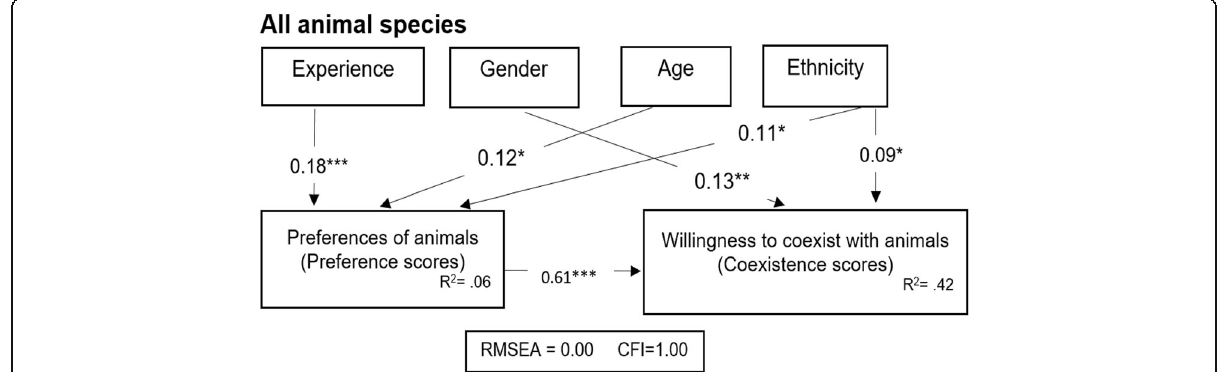
Fig. 2 Model with standardized estimates (non-significant paths not shown) predicting Preference and Coexistence using sociodemographic factors, namely, sex (male = 1, female = 0), age, ethnicity (Malay = 1, non-Malay = 0), and Experience level. Asterisks indicate significance levels (* p < 0.05; ** p < 0.01; *** p <